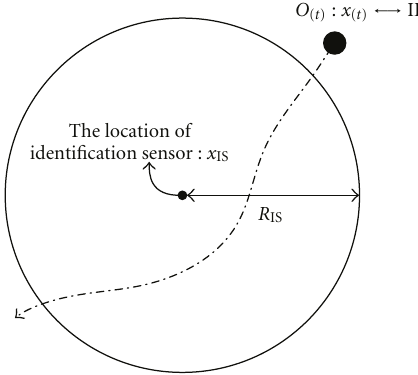
Figure 3: Example of an association and identification with an ideal sensor